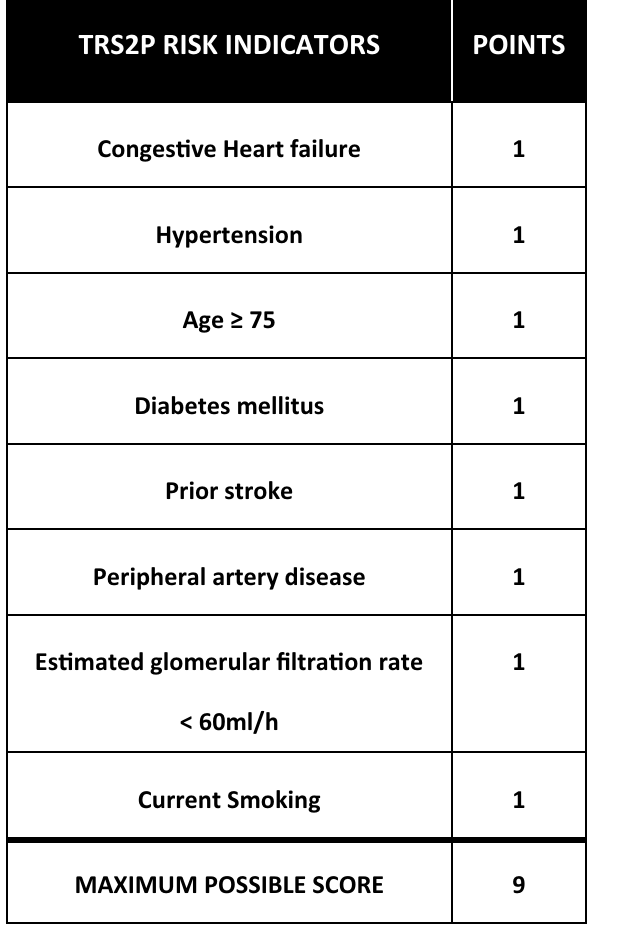
Figure 1. TRS2P risk indicators. Self-production. Source: Bohula et al. 26